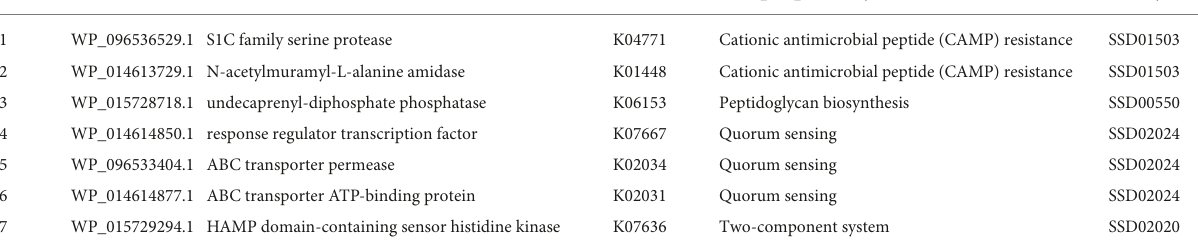
TABLE 1 S. pseudintermedius proteins involved in the unique metabolic pathways. Sr No. Protein